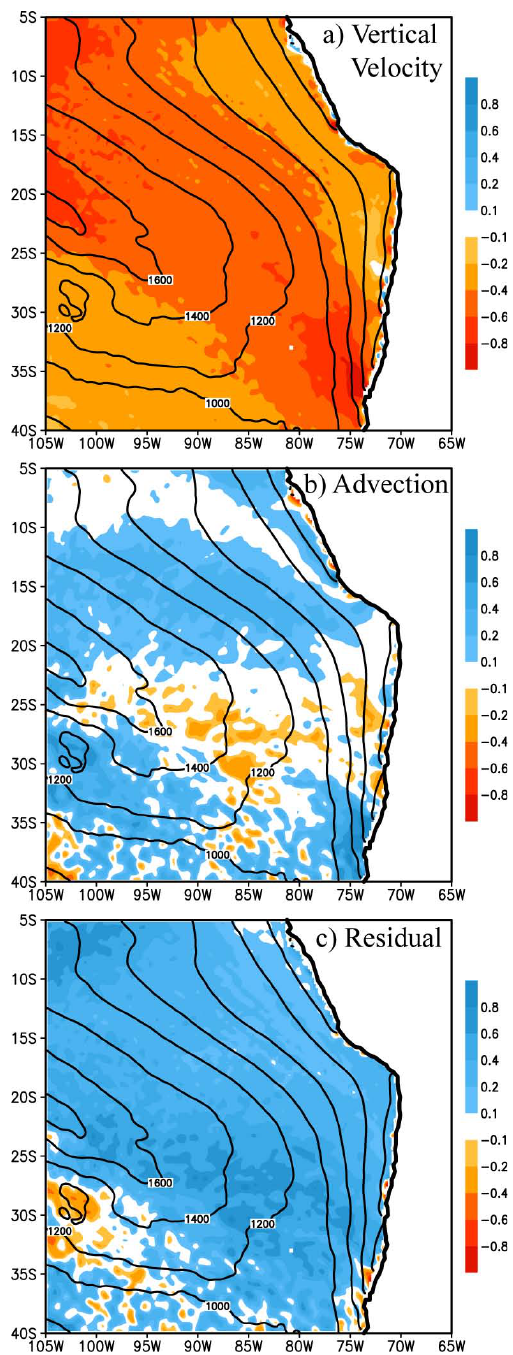
Fig. 6. October and November mean of (a) vertical velocity, (b) advection, and (c) residual (10 − 2 ms − 1 , color). Mean MBL height (m) shown by contours. All fields from the WRF simulation.